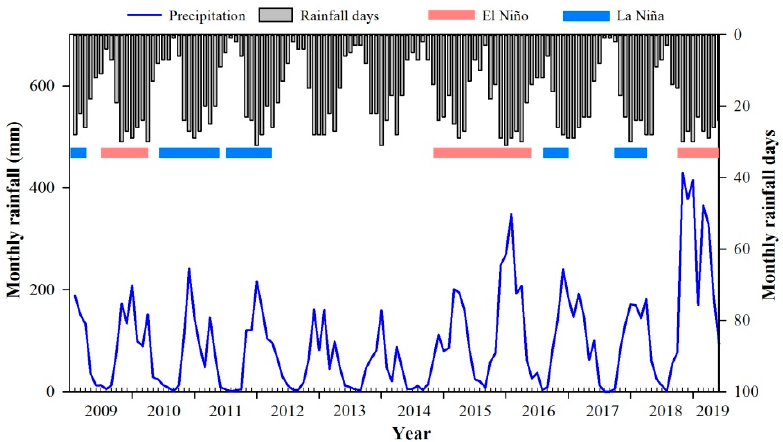
Figure 13. Daily precipitation in Brumadinho during the period from January to March 2019 [90].